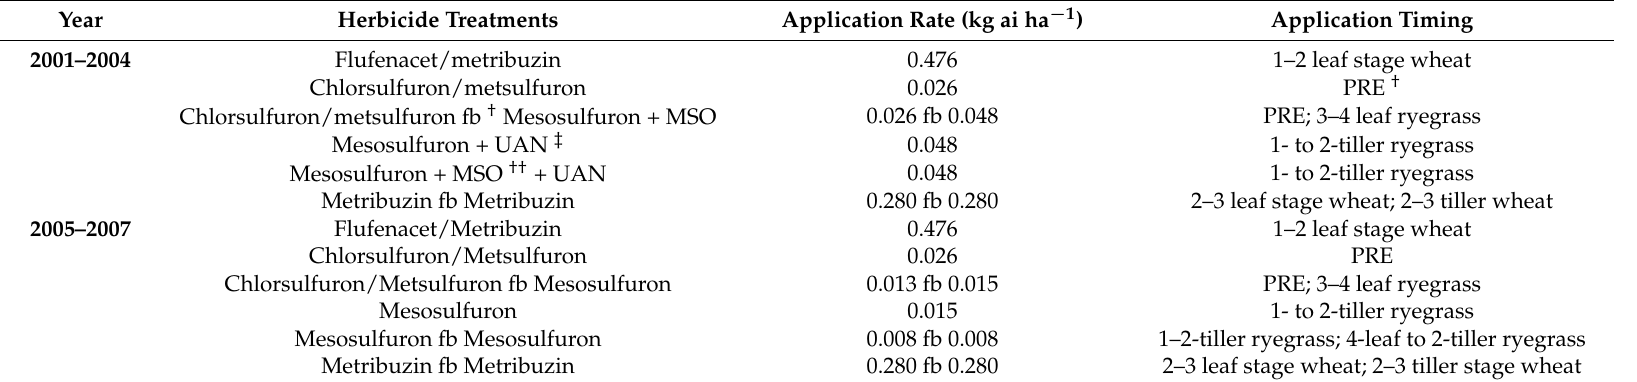
Table 3. Herbicide treatments, their application rate and application timing used in this study from 2001 to